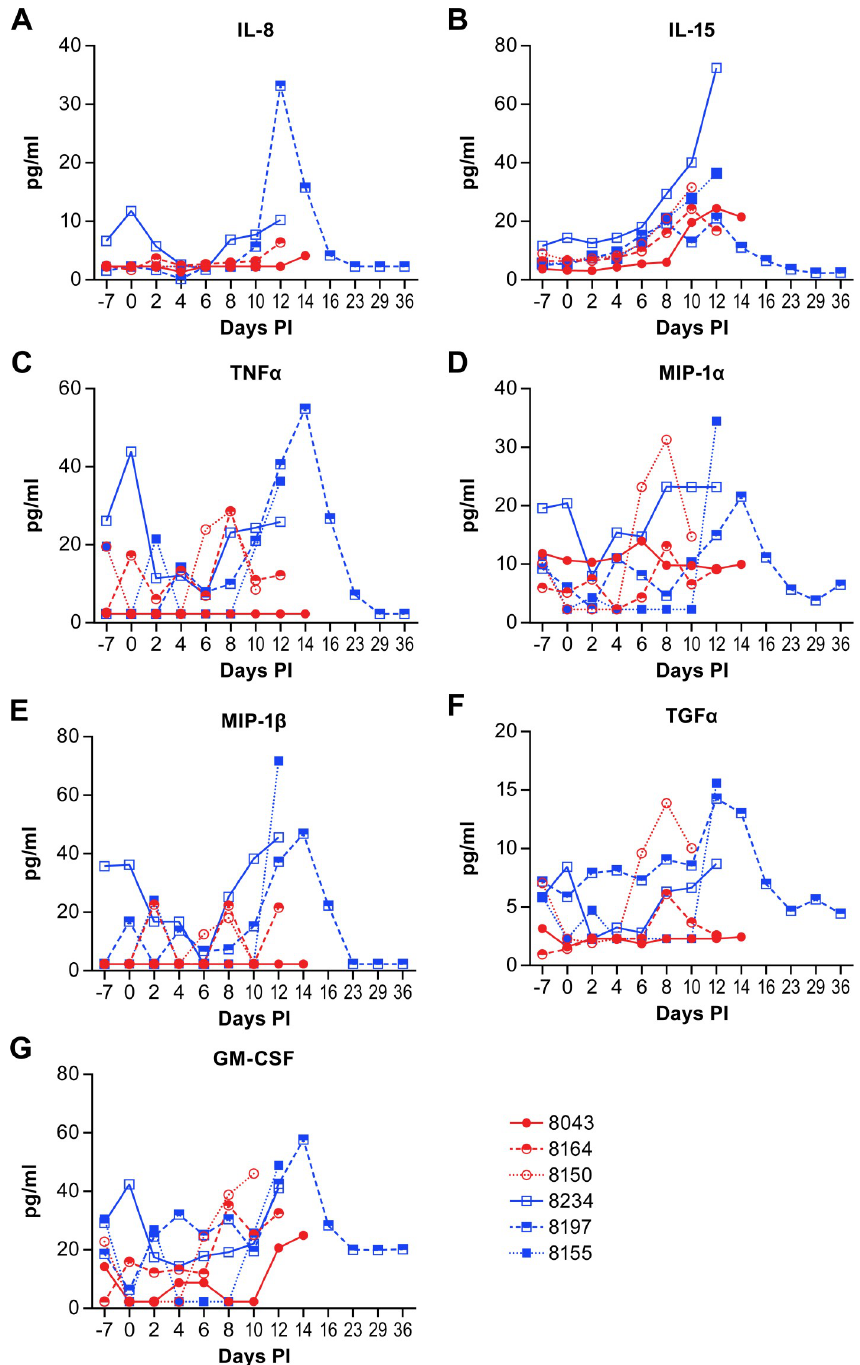
Fig 3. Plasma cytokine and chemokine levels in animals infected with NiV. IL-8 (A), IL-15 (B), TNF α (C), MIP-1 α (CCL3) (D), MIP-1 β (CCL4) (E), TGF α (F) and GM-CSF (G) levels in individual animals over the course of disease following NiV infection. Animals in the low dose group are displayed as red circles and those in the high dose group as blue squares. Values represent the mean of triplicate technical replicates.